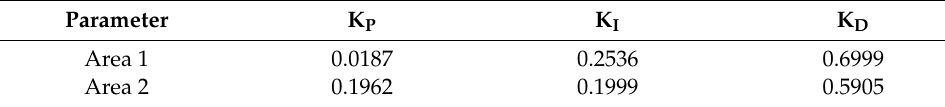
Table 5. PID controller parameters with non-linearities.